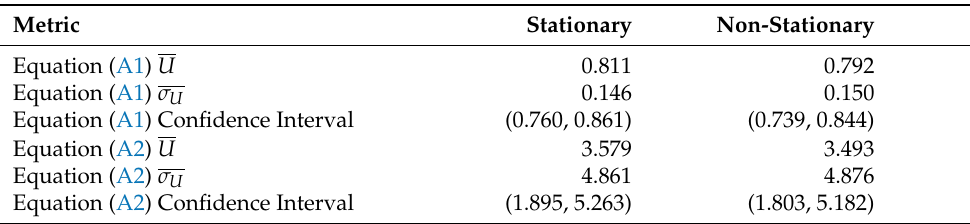
Table A5. Statistic U i for Capturing Variance in the Data. Values are rounded to the nearest 3 decimal